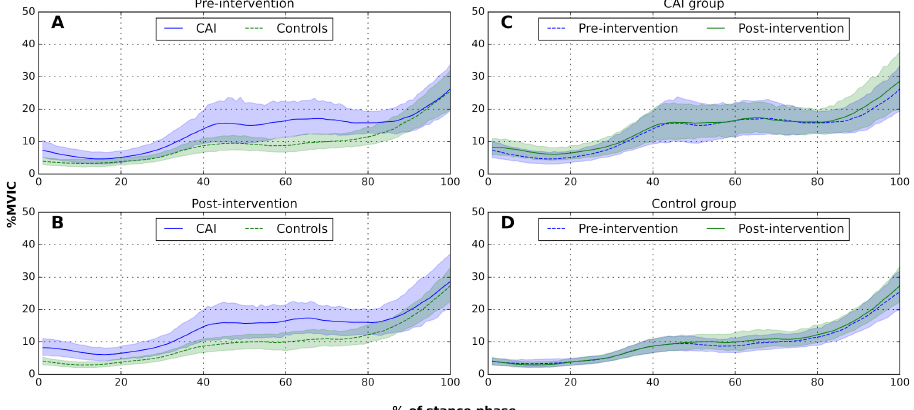
Figure 3. Between- and within-group comparisons of peroneal electromyography during the stance phase of gait: ( A ) before intervention, between groups; ( B ) after intervention, between groups; ( C ) CAI group, pre/post-intervention; ( D ) control group, pre/post-intervention. Solid and dashed lines represent group means. Green and blue shaded areas represent a 95% confidence interval of the mean, at each data point.